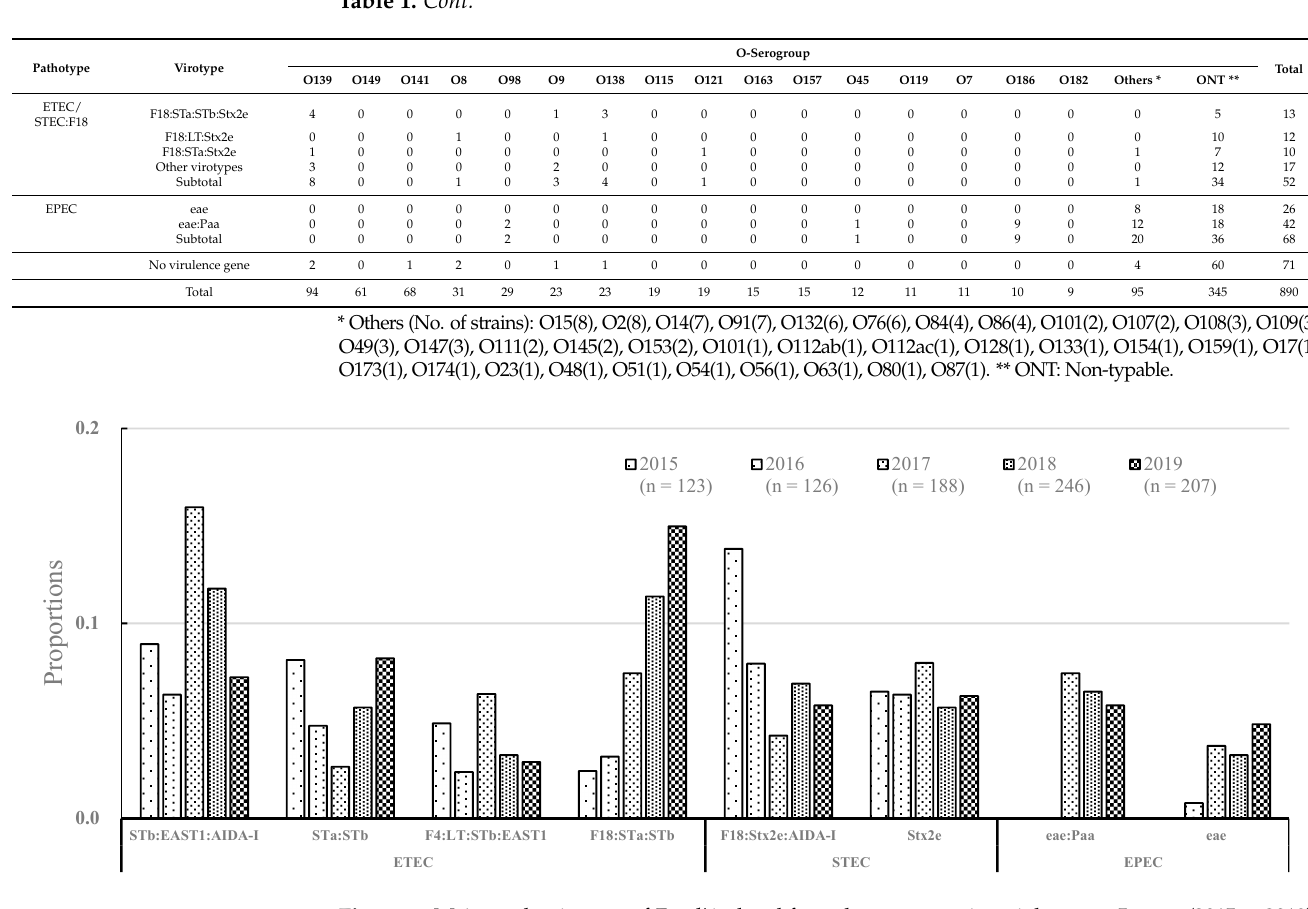
Figure 2. Major pathovirotype of E. coli isolated from the post-weaning piglets over 5 years (2015 to 2019).